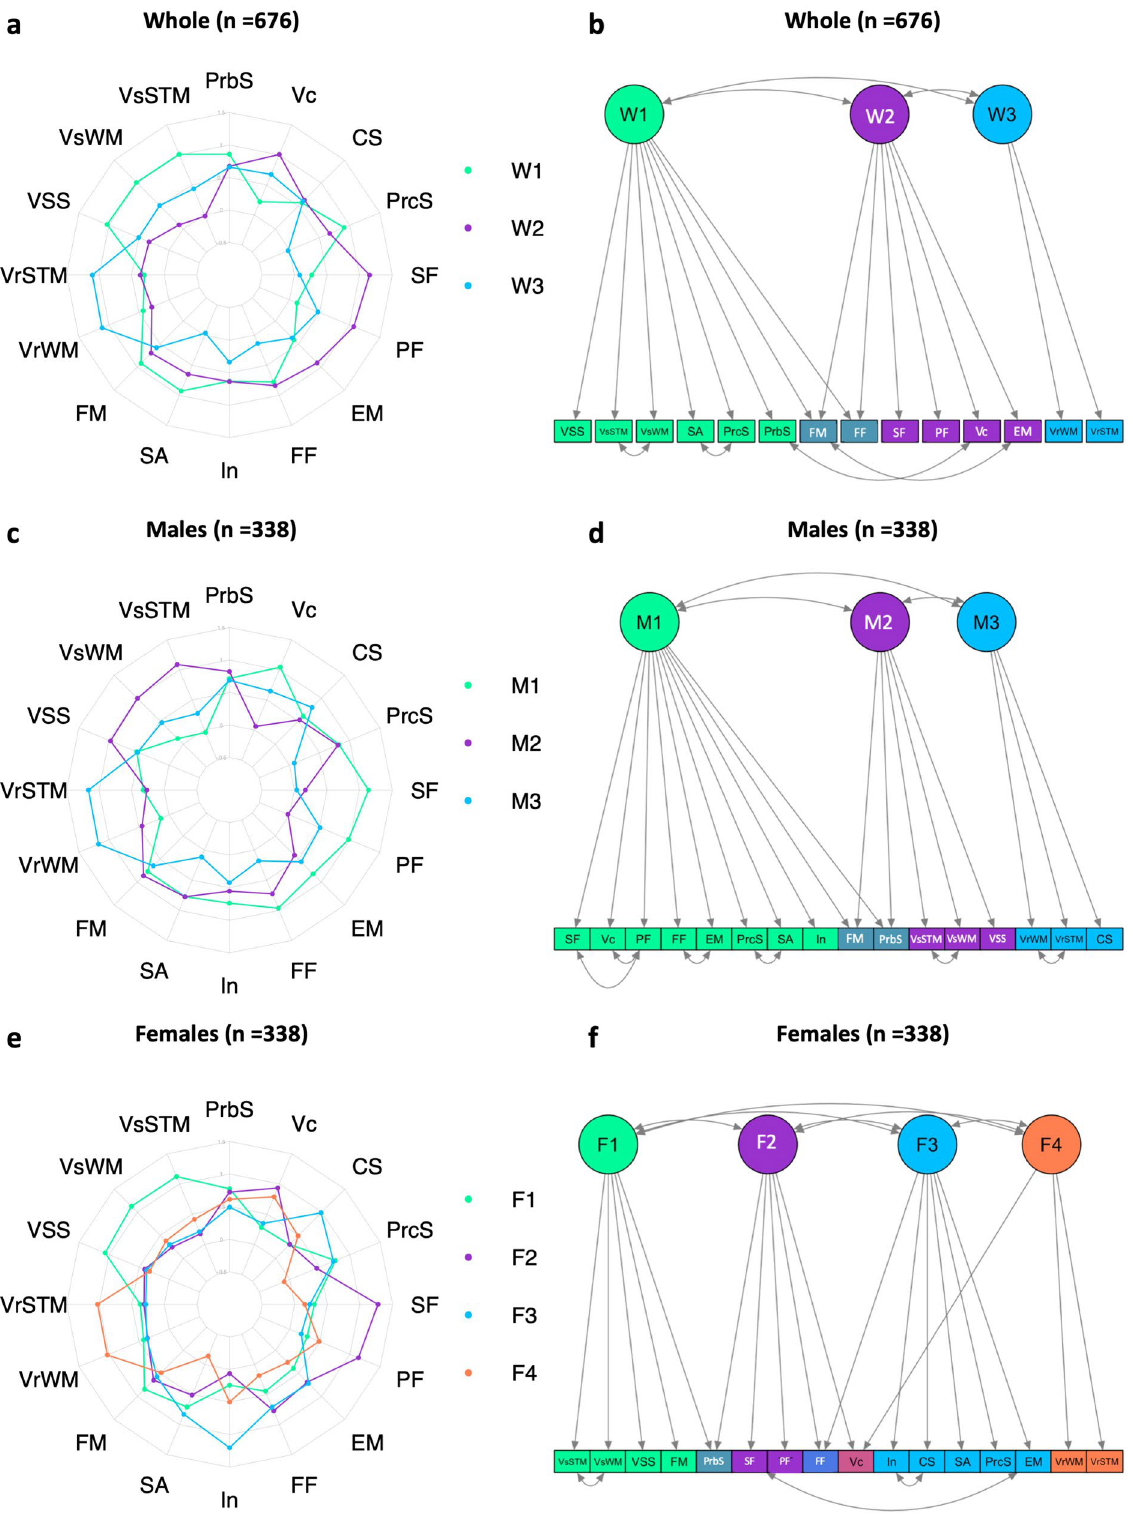
Figure 3. Exploratory Principal Component Analysis (ePCA) and Confirmatory Factor Analysis (CFA): ( a , c , e ): ePCA for the whole group, males and females. ( b , d , f ): CFA for the whole group, males and females. PrbS problem solving, VsSTM visual spatial short-term memory, VsWM visual spatial working memory, VSS visual working memory, VrSTM verbal short-term memory, VrWM verbal working memory, FM figural memory, SA selective attention, In interference, FF figural fluency, EM episodic memory, PF phonemic fluency, ST semantic fluency, PrcS processing speed, CS concept shifting, Vc